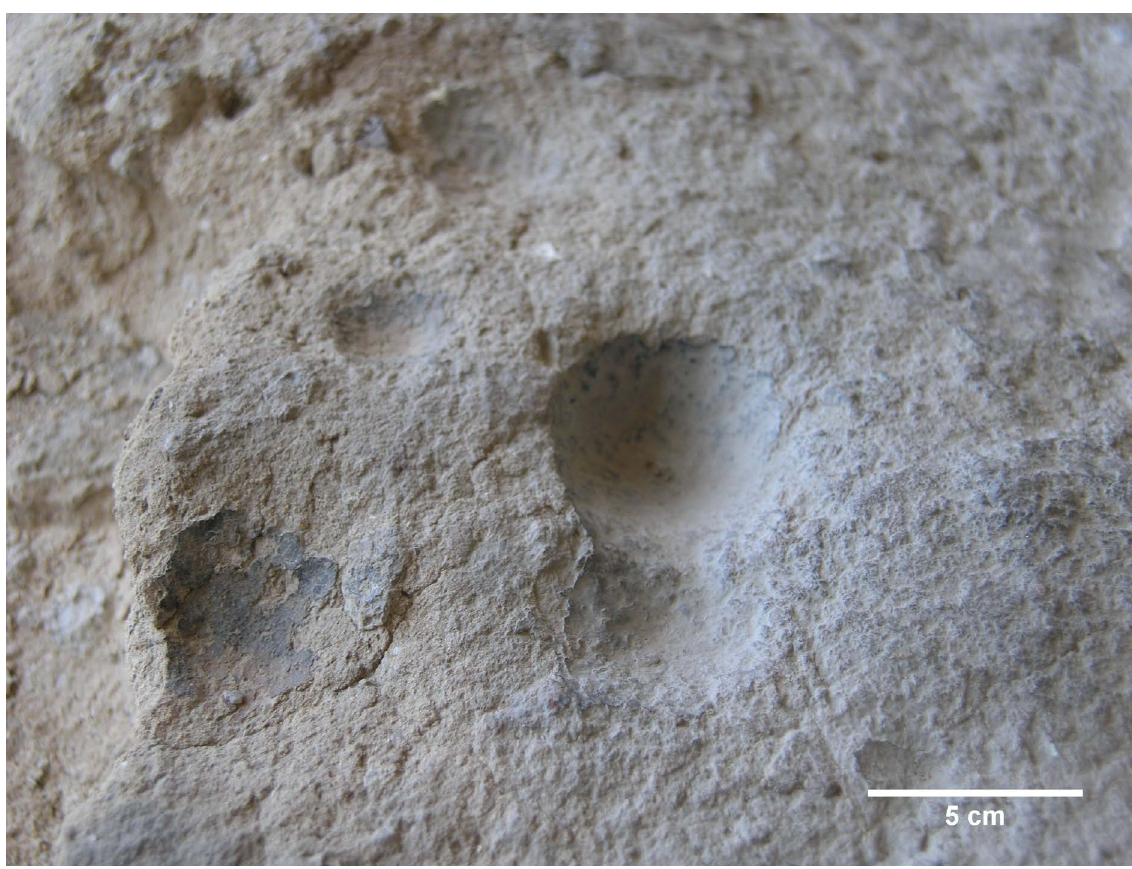
Figure 5. Blackened surface residues in RMP-5 cupules. Scale is